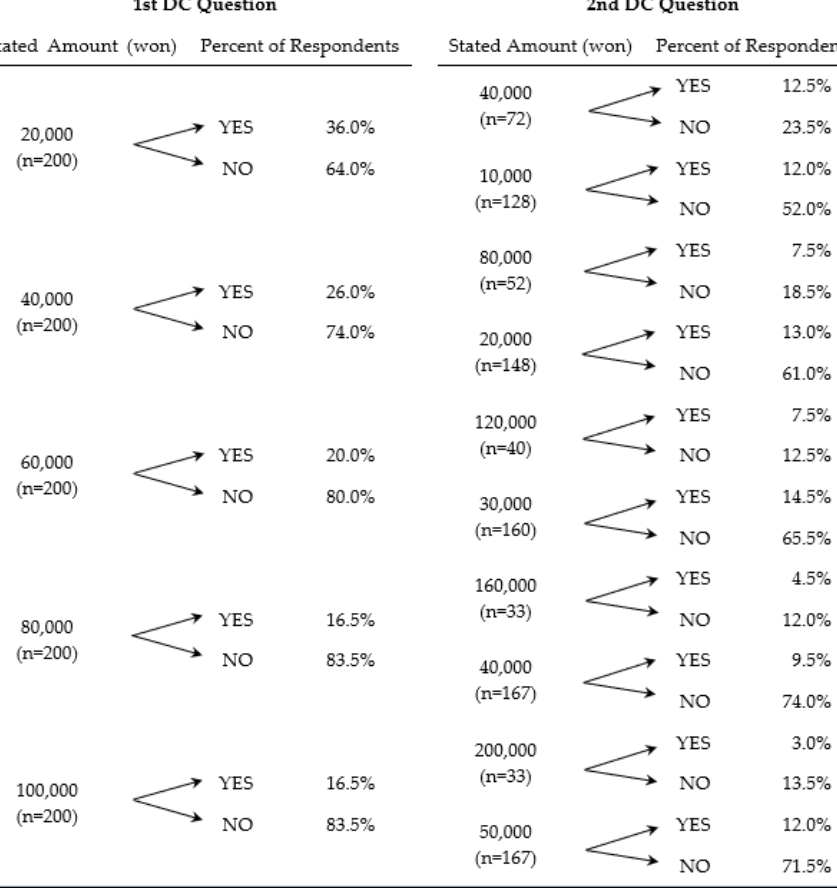
Figure 3. Summary responses to double-bounded dichotomous choice questions. All percentages are calculated from the total number of respondents for each stated amount (n = 200).